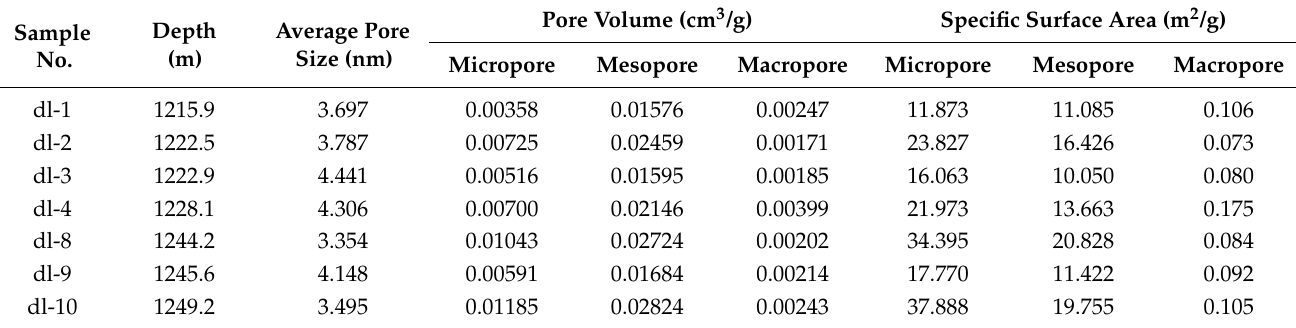
Table 2. Pore structure parameters of Dalong Formation shale samples from well